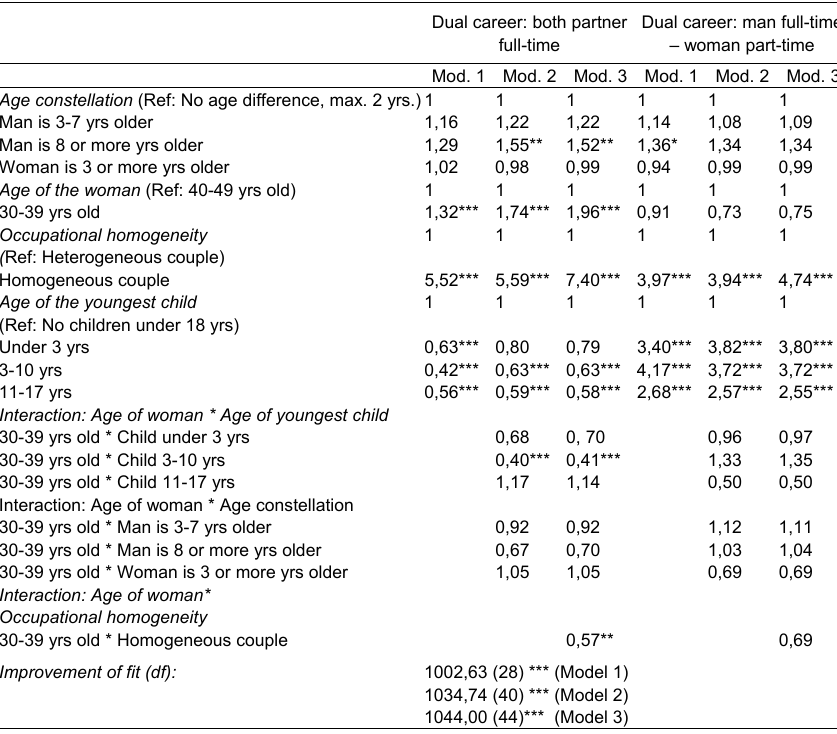
Multinomial logistic regressions on the chance of realizing dual careers in academic couples (reference category: no dual career) (odds ratios, N = 3,284 couples in which both partners are employed) Dual career: both partner Dual career: man full-time full-time – woman